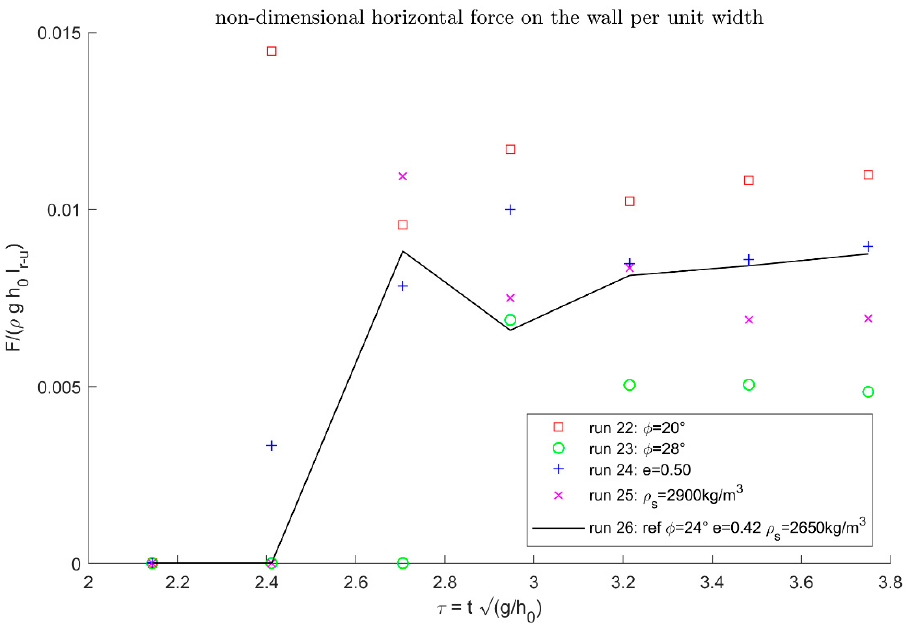
Figure 7. E ff ects of geotechnical parameters variation on the impact force on the vertical downstream